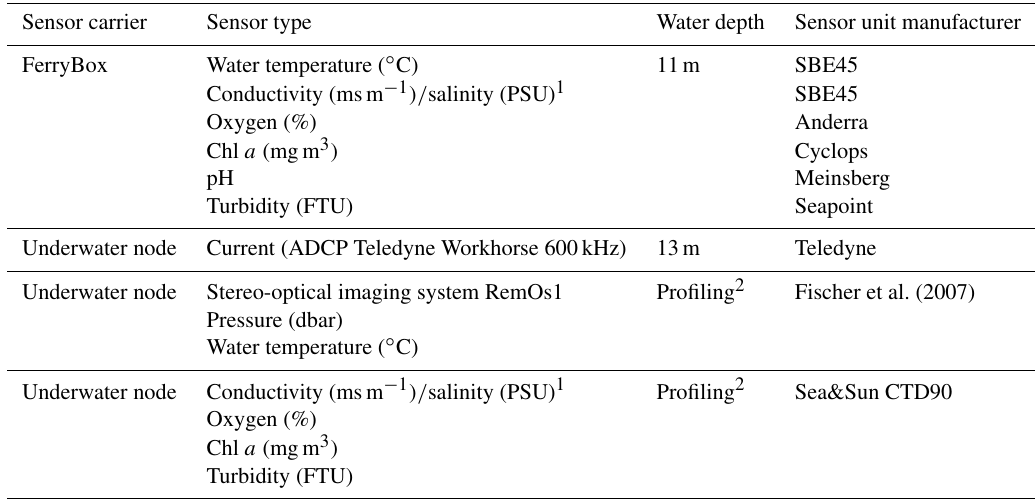
Table 1. Sensors attached to the COSYNA@AWIPEV UWO at UMT 8763953 ◦ N, 433992 ◦ E. The FerryBox has its water inlet at a fixed depth of 11m below mean sea level (http://vannstand.no/index.php/nb/english-section/sea-level-data). The RemOs1 system is profiling from 11m water depth to the surface (for further descriptions, see the